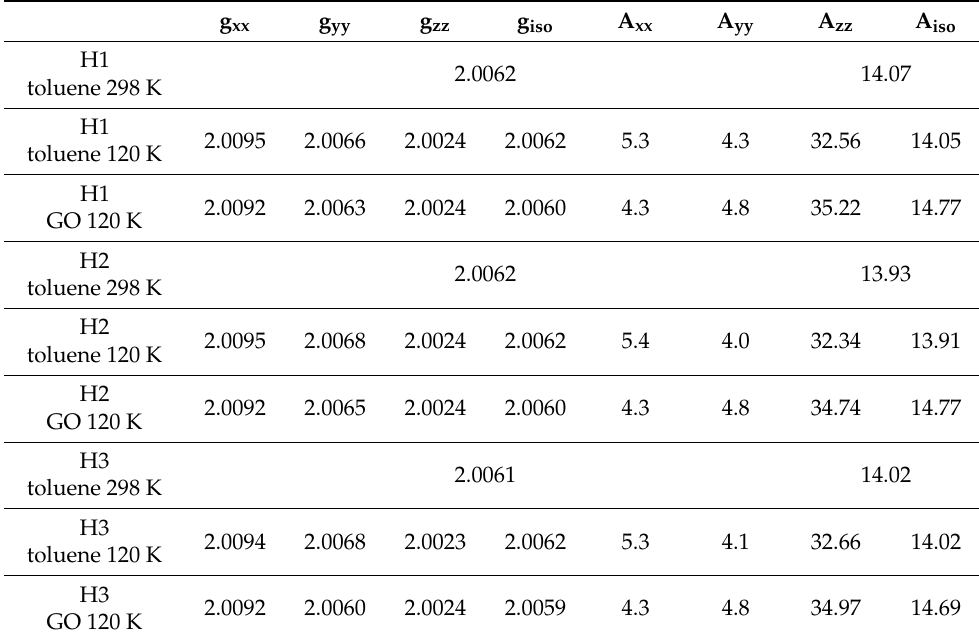
Table 1. Spin-Hamiltonian parameters of nitroxide radicals in toluene and on inner surface of graphite